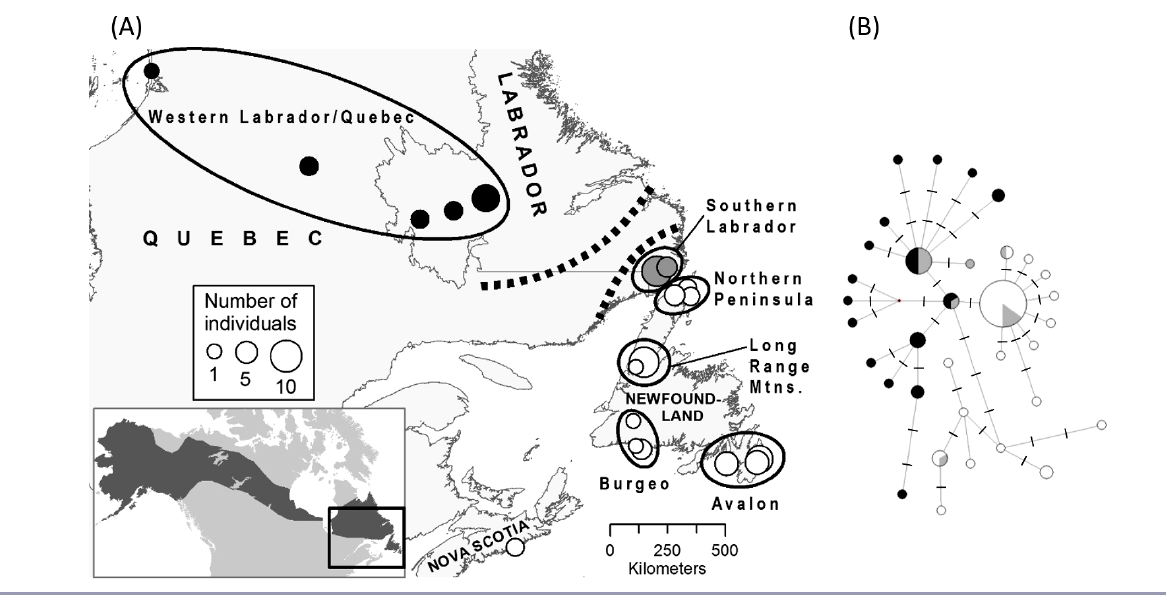
Fig. 1 . Population samples and ND2 haplotype network for Gray-cheeked Thrushes ( Catharus minimus ; n = 77). (A) Circles denote locations and sizes of samples; ellipses denote regional groupings for pairwise φ st analysis. The dotted lines represent the putative range gap between thrush subspecies. The inset map shows the breeding range of Gray-cheeked Thrush (dark gray). (B) Minimum spanning haplotype network of 77 ND2 sequences (1041 base pairs), where each tic mark along branches equals one nucleotide substitution. Twelve individuals from southern Labrador are illustrated in grey, half of which cluster with thrushes from western Labrador (black) and the other half of which cluster with those from Newfoundland (white). Samples from Alaska (n = 7) and Siberia (n = 3) are included in the haplotype network (black) but are not illustrated on the